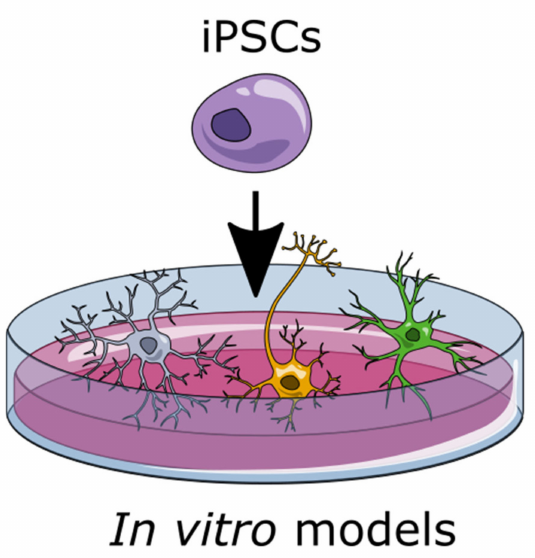
Figure 2. Induced pluripotent stem cells (iPSCs) can be used to create a variety of different cell types, including astrocytes, microglia, and